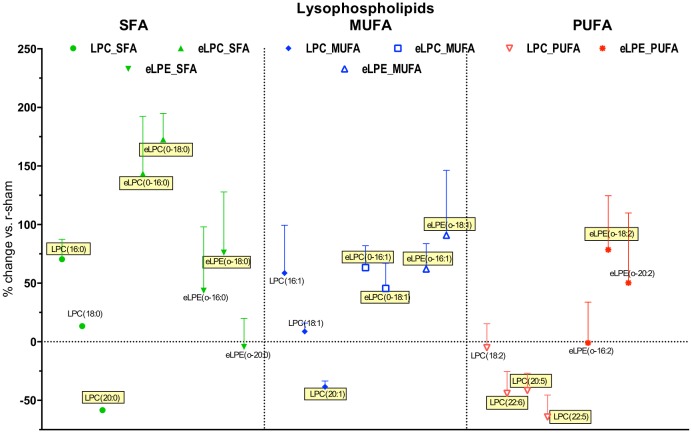
Effect of r-mTBI on lyso-phospholipid species detected in the present study based on degree of unsaturation.Saturated fatty acid species (SFA) are presented in green, monounsaturated fatty acid species (MUFA) are presented in blue, while polyunsaturated fatty acid species (PUFA) are presented in red. Symbols represent mean values of percent change of r-mTBI samples compared to r-sham samples; error bars indicate SEM. Note 1: due to the large number of PUFA species detected, only the ones showing > ±25% change are presented. Note 2: Species names covered with yellow boxes indicate statistical significance (p<0.05).